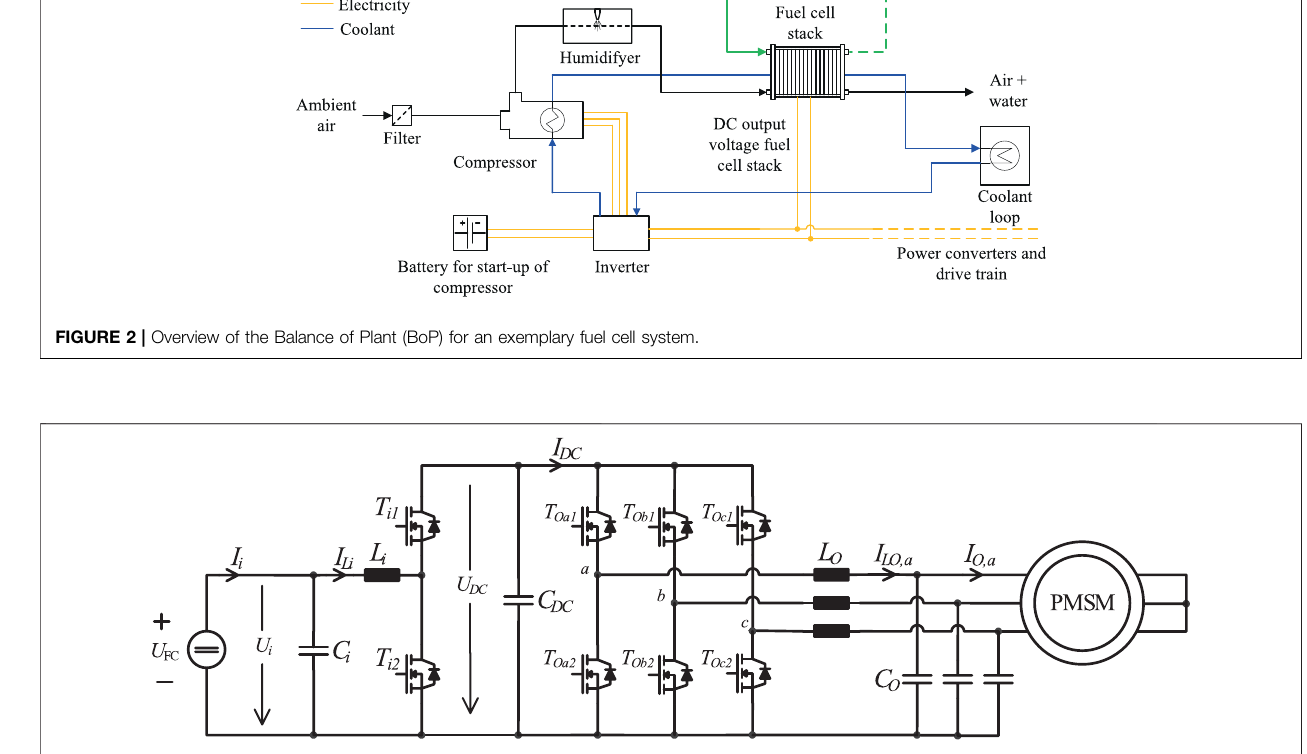
FIGURE 3 | State-of-the-art single-bridge voltage source inverter (SB-VSI) solution for motor drives with a wide input-output voltage range. The SB-VSI is a two- stage converter; i.e., a dedicated DC/DC stage steps the battery voltage U i up to a higher dc link voltage U dc , while a DC/AC stage generates the three-phase motor voltage system. A differential-mode/common-mode (DM/CM) fi lter is placed before the motor in order to protect the latter from high d u /d t